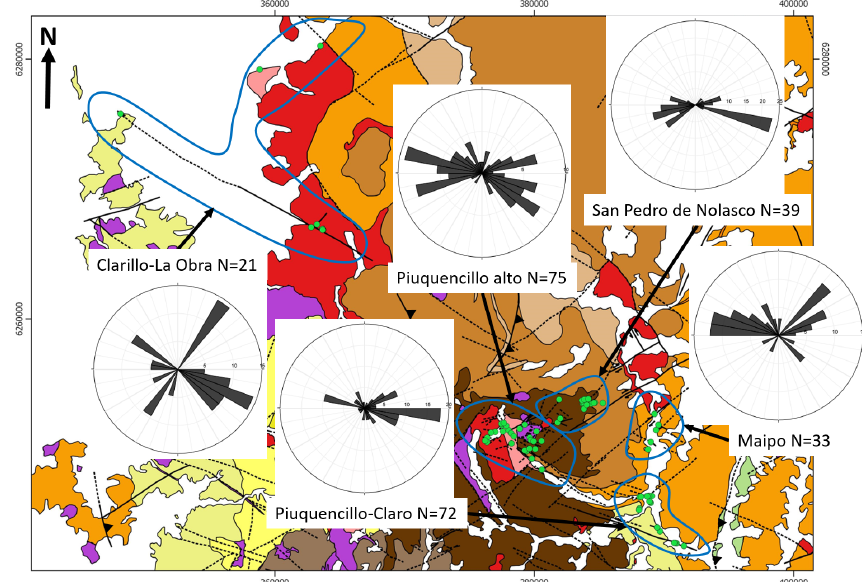
Figure 9. Preferred orientations of fault planes in the five sectors into which the study area was subdivided. The geological map in the background was compiled from Rivera and Cembrano (2000), SERNAGEOMIN (2002), Fock (2005), Fock et al. (2005), Piquer (2015) and this work.